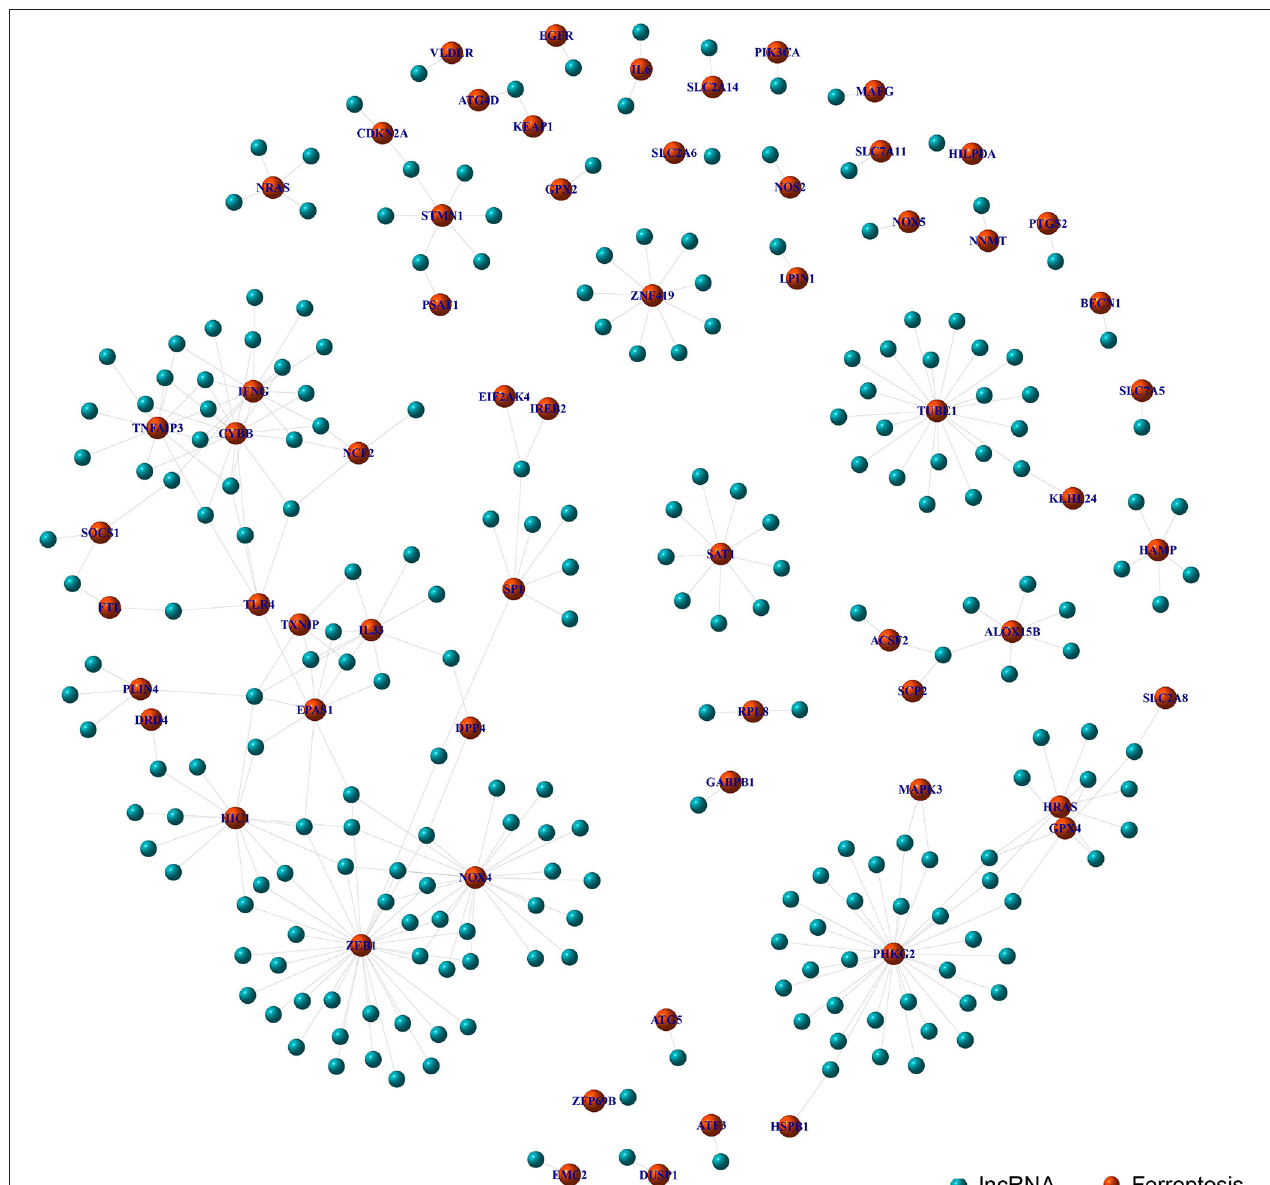
FIGURE 1 | Co-expression network analysis on target LncRNAs related to ferroptosis-related genes. The red node represents the ferroptosis-related genes and the blue node represents the LncRNA coexpressed with the ferroptosis-related genes.